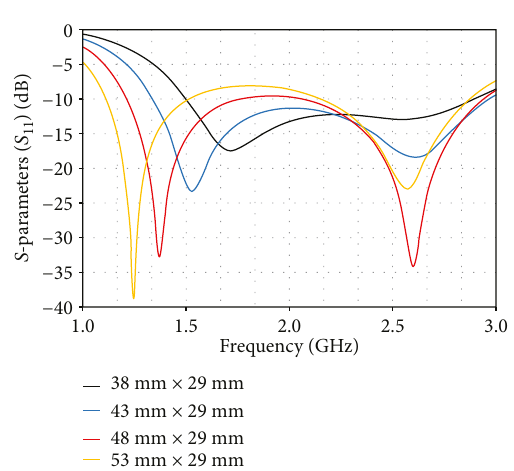
11 of foldable antenna with